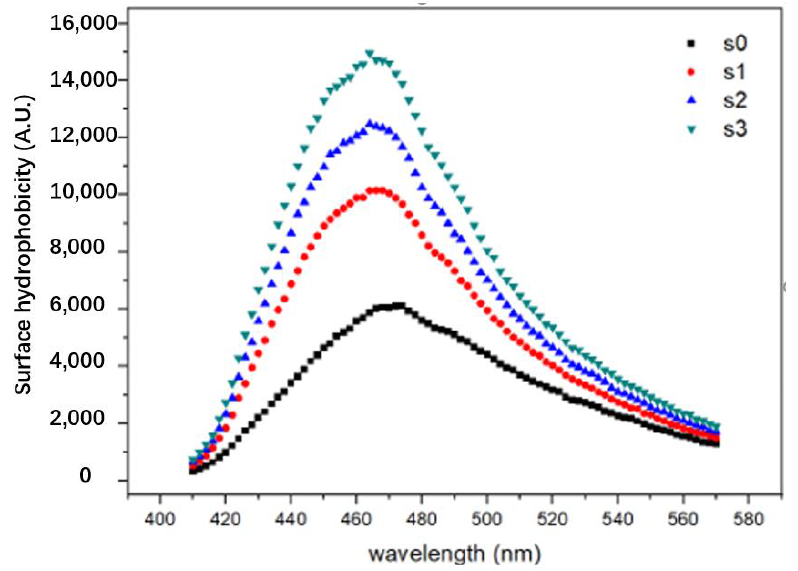
Figure 1. Fluorescence changes of EPI isolate cross-linked under different enzyme concentrations (0 u/g, 10 u/g, 20 u/g, 40 u/g).